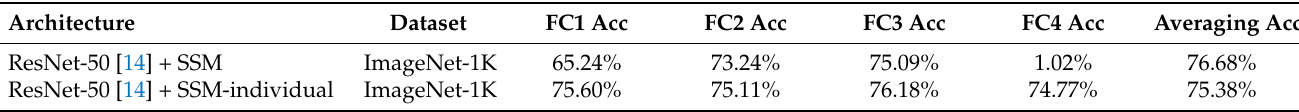
Table 2. Results of ImageNet-1K classification according to two different training schemes.